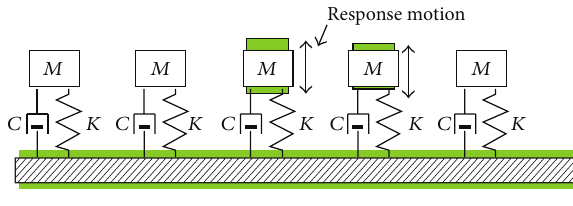
Figure 1: SDOF systems for calculation of